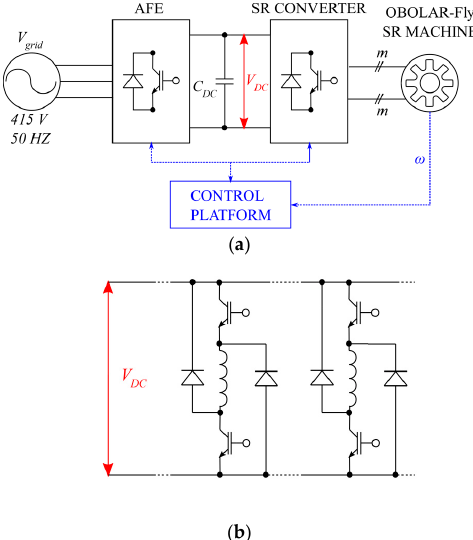
Figure 2. One-body and laminated rotor flywheel (OBOLAR-Fly) switched reluctance (SR) system: ( a ) schematic overview; ( b ) SR unidirectional, H-bridge converter topology.